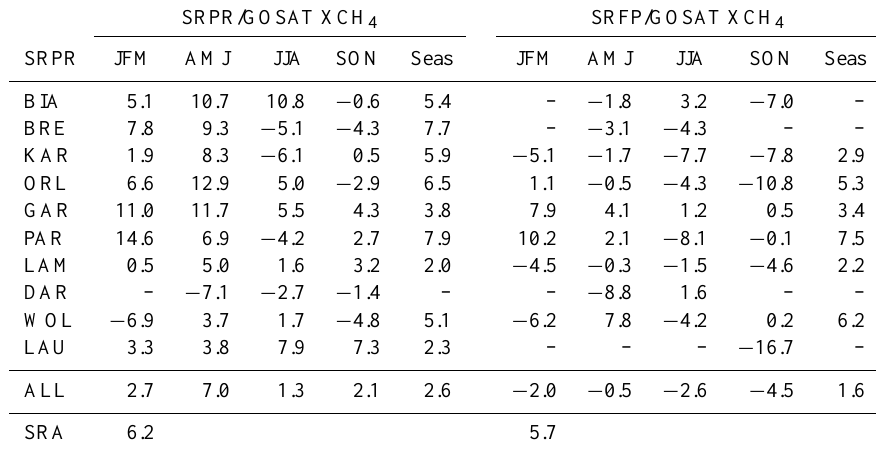
Table 12. SRPR and SRFP XCH 4 seasonal mean bias, seasonality and SRA results. All results are in ppb units.